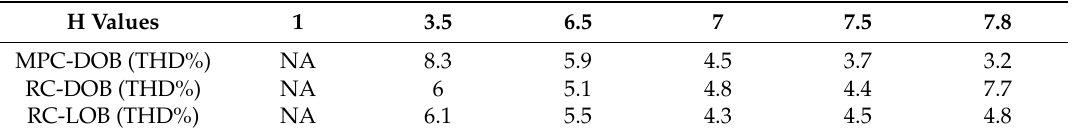
Table 2. Comparison of the voltage THD values for di ff erent η under the nonlinear load ( R nl =